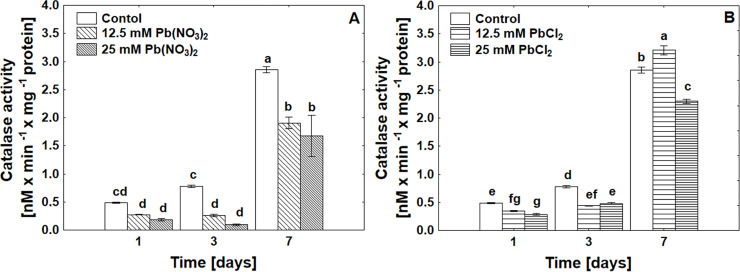
Catalase activity in P. sylvestris seeds under control, Pb(NO3)2 (A) or PbCl2 (B) treatments in concentrations of 12.5 mM and 25 mM after 1, 3 and 7 days of germination, ANOVA, Duncan Test p≤0.05.